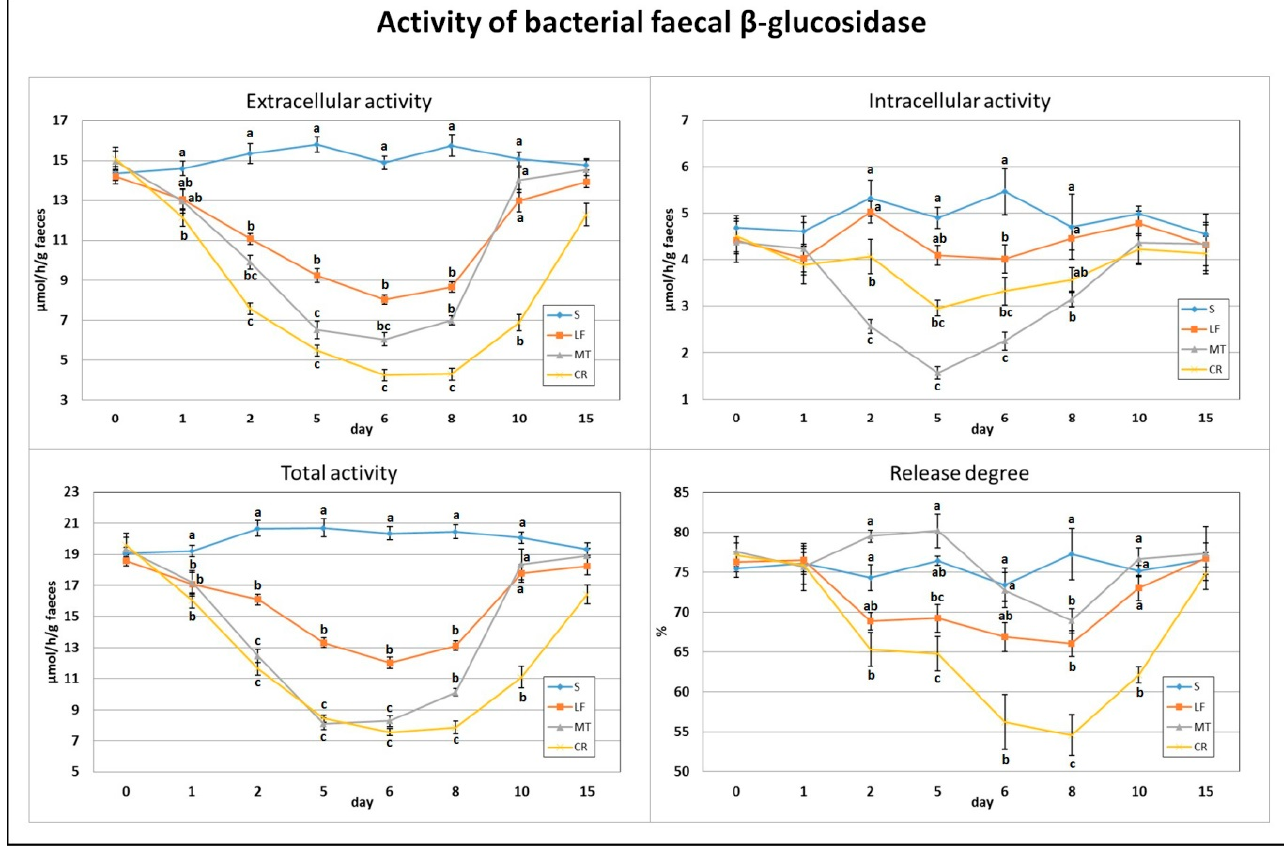
Figure 1. Experimental factor in particular groups: S—control standard diet (0–15 days); LF—standard diet with lactoferrin addition 100 mg/kg (0–5 days diet LF and 6–15 days diet S); MT—standard diet with melittin addition 100 mg/kg (0–5 days diet MT and 6–15 days diet S); CR—standard diet with cecropin A addition 100 mg/kg (0–5 days diet CR and 6–15 days diet S). a,b,c Mean values on the day with no common superscript are different at p ≤ 0.05. Data are presented as the mean with SEM; SEM—SD for all rats divided by the square root of rat number in one group ( n = 8). Release degree, extracellular expressed as percent of total activity.